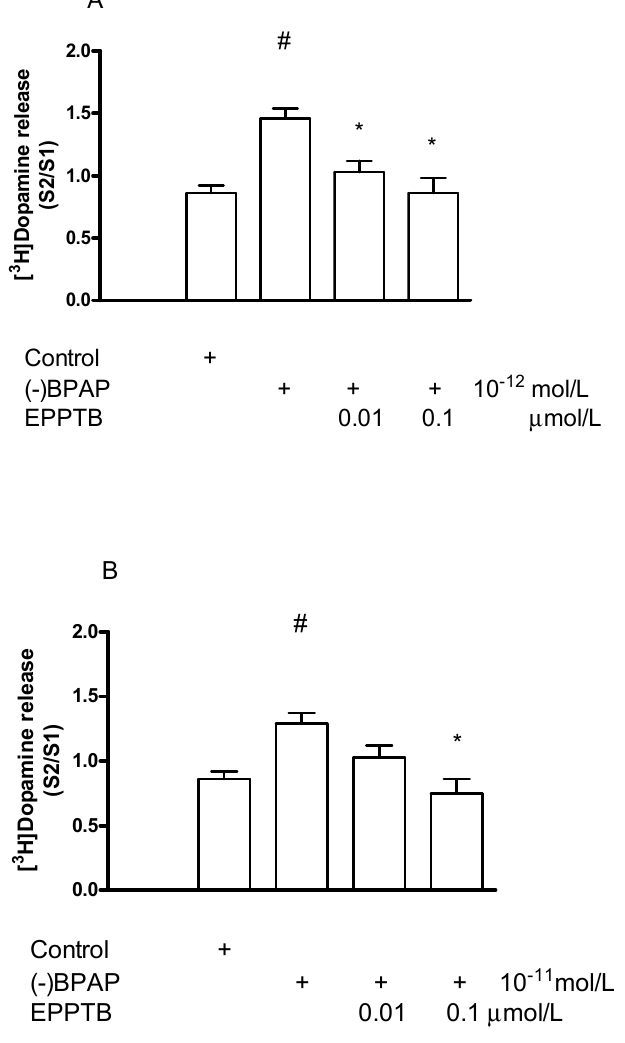
Figure 12. EPPTB reversed the ( − )BPAP-induced [ 3 H]dopamine release in rat striatum. For the experimental procedure, see Figure 2A. ( − )BPAP was added to striatal slices from fraction 8 in a concentration of either 10 − 12 ( A ) or 10 − 11 mol/L ( B ) in the presence and absence of EPPTB. When used, EPPTB was added to striatal slices from fraction 1 in a concentration of either 0.01 or 0.1 µ mol/L and drugs were maintained through the experiment. ( A ) One-way ANOVA followed by the Dunnett’s test, F(3,28) = 12.310, p < 0.001, # p < 0.01; Student t -statistics for two-means, control vs. ( − )BPAP effect p < 0.05, ( − )BPAP vs. ( − )BPAP, and EPPTB (0.01 and 0.1 µ mol/L) effects * p < 0.01, mean ± S.E.M., n = 7-10. ( B ) One-way ANOVA followed by the Dunnett’s test, F(3,23) = 3.890, p = 0.022, Student t -statistics for two-means, control vs. ( − )BPAP effect # p < 0.01, ( − )BPAP vs. ( − )BPAP and EPPTB (0.1 µ mol/L) effect * p < 0.01, mean ± S.E.M., n =